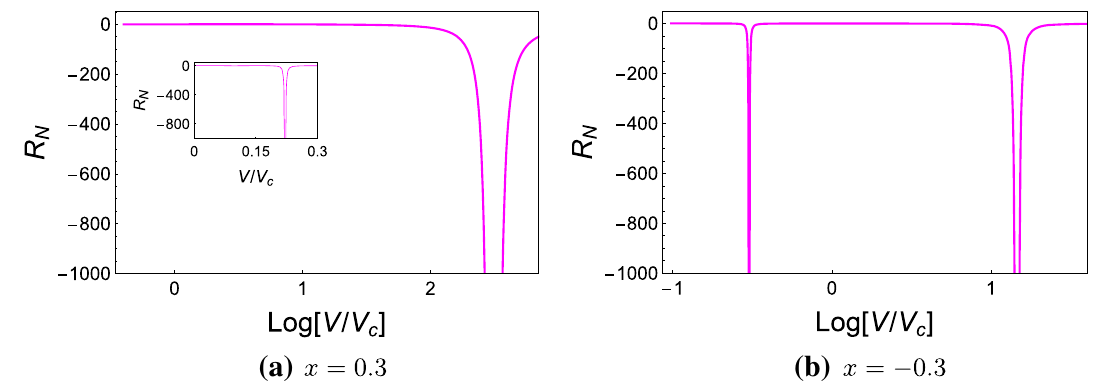
Fig. 5 The normalized scalar curvature of dRGT black hole as function (cid:13) V with x = 0 . 3, − 0 . 3, and (cid:13) T = 0 . 4